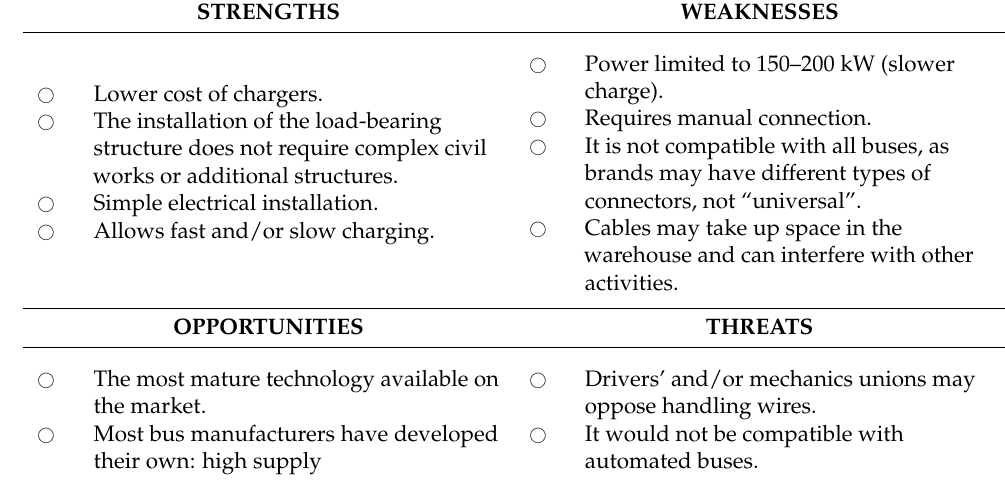
Table 3. SWOT analysis of Wire Charging.